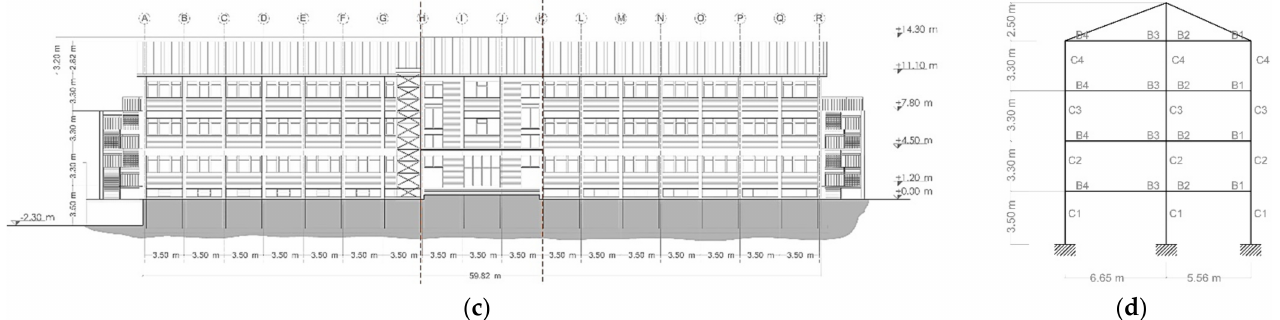
Figure 5. ( a ) Plan; ( b ) transverse section; ( c ) elevation; ( d ) modelled frame. The structural joint originally designed for thermal deformations are highlighted by orange hidden lines.